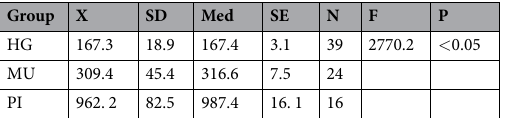
Table 2. Comparison of the concentration of HMGB1 (pg/ml) in different stages of peri-implant disease. X , mean; SD , standard deviation; Med , median; SE , standard error; N , number; F, f value. The concentrations of HMGB1 in different stages of peri-implant disease were compared with a one-way